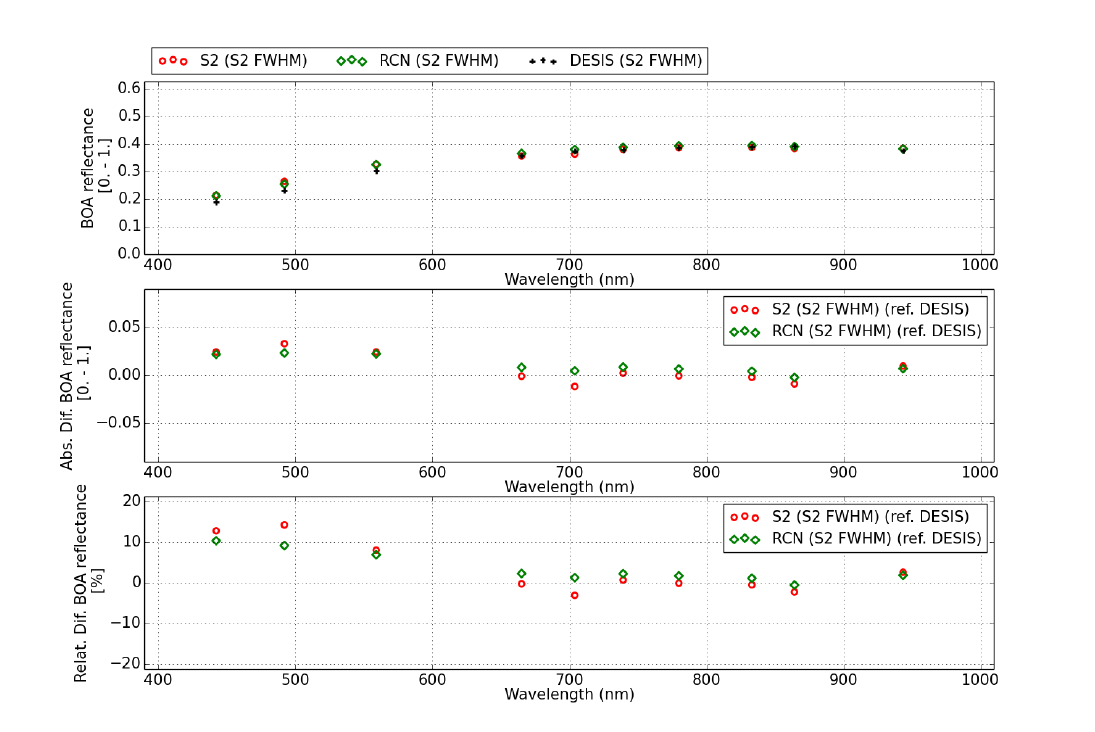
Figure 8. Surface reflectance for Sentinel-2B, DESIS and the Railroad Valley Playa RadCalNet (RCN) site of 28 June 2019. The spectra are convolved with Sentinel-2 spectral response function and the absolute and relative differences (middle, bottom plots) are calculated with respect to the DESIS